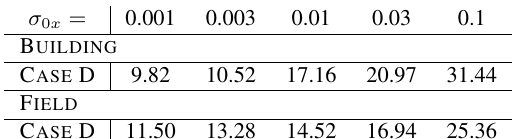
Table 2. The loss in accuracy ∆ F C in percent of estimated ASE D pose parameters at noise level σ 0 l = 0 . 0001 and different relative precision σ 0 x of approximate values, both in